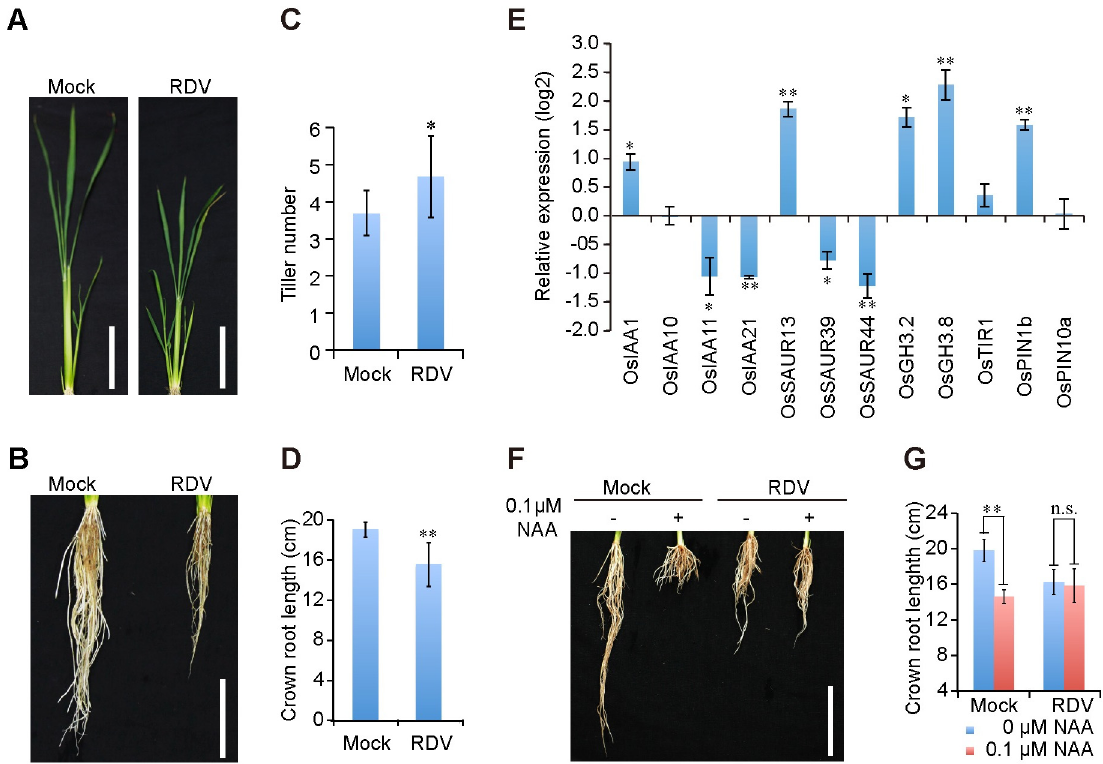
Fig 1. RDV infection disturbs auxin pathway in rice. (A and B) Aboveground (A) and root (B) phenotypes of mock- and RDV- infected rice plants at 6-week-old seedling stage. Bars: 10 cm. (C and D) Schematic representation of the tiller number and crown roots length of mock- and RDV- infected rice plants in (A) and (B). The average ( ± standard deviation (SD)) values were obtained from three biological repeats, with 15 plants from each line in every repeat. Significant differences were indicated ( * P < 0.05, ** P < 0.01) based on Student ’ s t -test. (E) Relative average expression (log2) of auxin-induced genes in RDV-infected rice plants. Data were obtained from qPCR assays and analyzed using 2 - ΔΔ C(t) method and the OsEF1a mRNA levels were used as internal controls. Values are mean ± SD (n = 3 biological replicates). Columns with asterisks are statistically different according to Student ’ s t -test ( * P < 0.05, ** P < 0.01) as compared to their expression in mock-inoculated rice plants. (F and G) RDV-infected rice plants exhibit reduced sensitivity to auxin treatment. Phenotypes (F) and lengths (G) of crown roots of mock- and RDV- infected 4-week-old seedlings cultured in liquid nutrition containing 0 or 0.1 μ M NAA for 10 days. Bar: 10 cm. The average ( ± SD) values were from three biological repeats with 15 plants for each line every repeat. Significant differences were indicated (n.s., no significant, ** P < 0.01) based on Student ’ s t